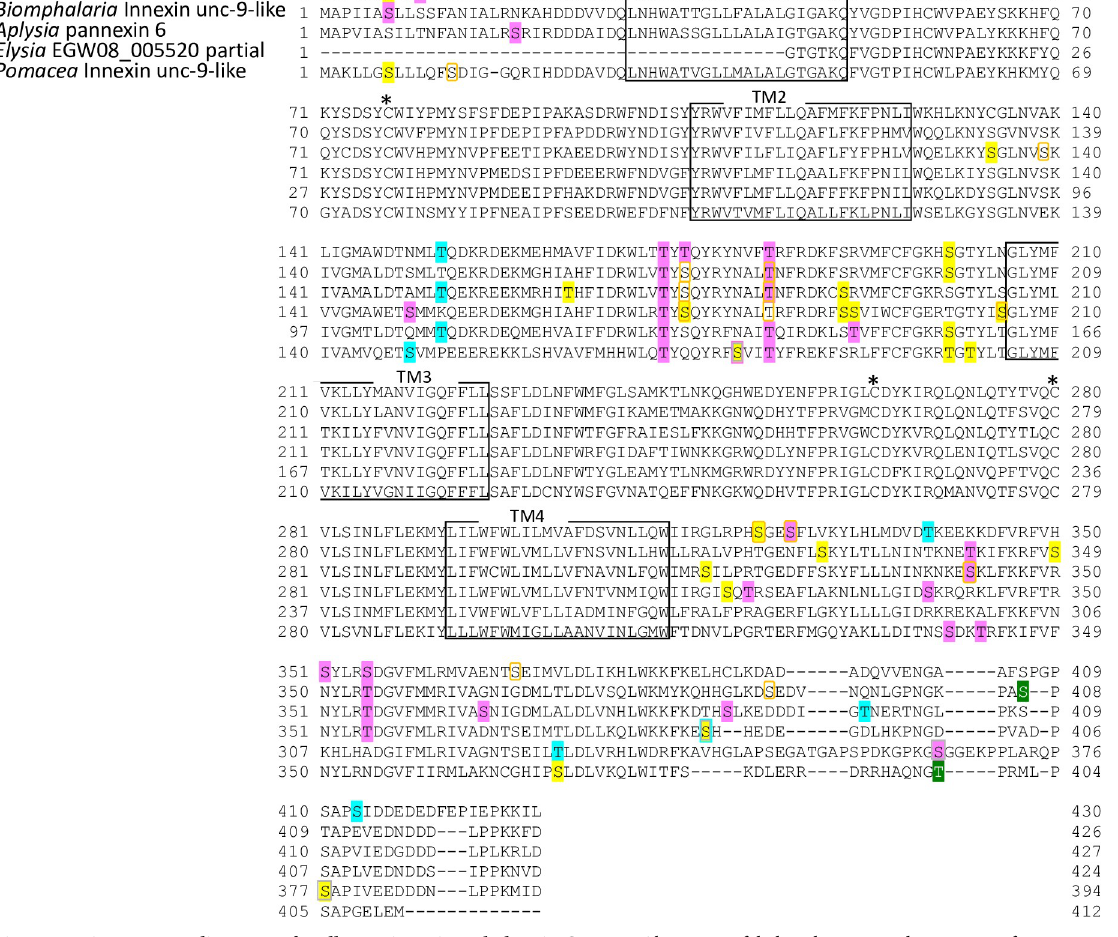
Fig 8. Protein sequence alignment of molluscan innexin orthologs in Group 6. Alignment of deduced amino acid sequences of Limax innexin 10 with orthologous innexin sequences. The boxes show the four transmembrane domains, while the asterisks indicate the extracellular cysteine residues. The phosphorylation sites are indicated with shading or box in magenta (protein kinase C), yellow (protein kinase A), cyan (casein kinase 2), orange (P34cdc2), green (p38-mitogen-activated protein kinase), and gray (protein kinase